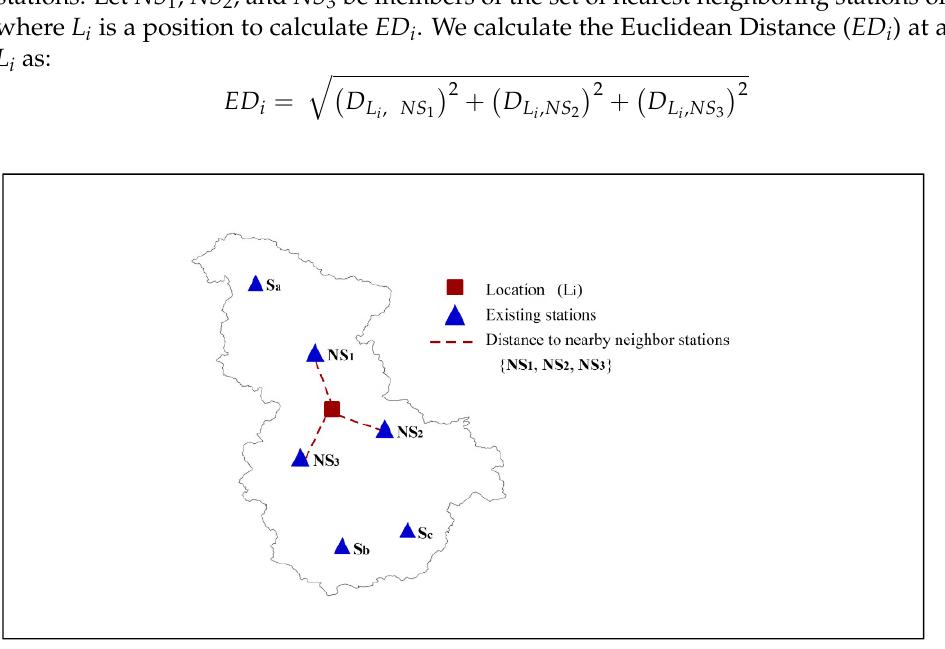
Figure 3. The location of L i and its nearest neighbor stations NS 1 , NS 2 , and NS 3 .